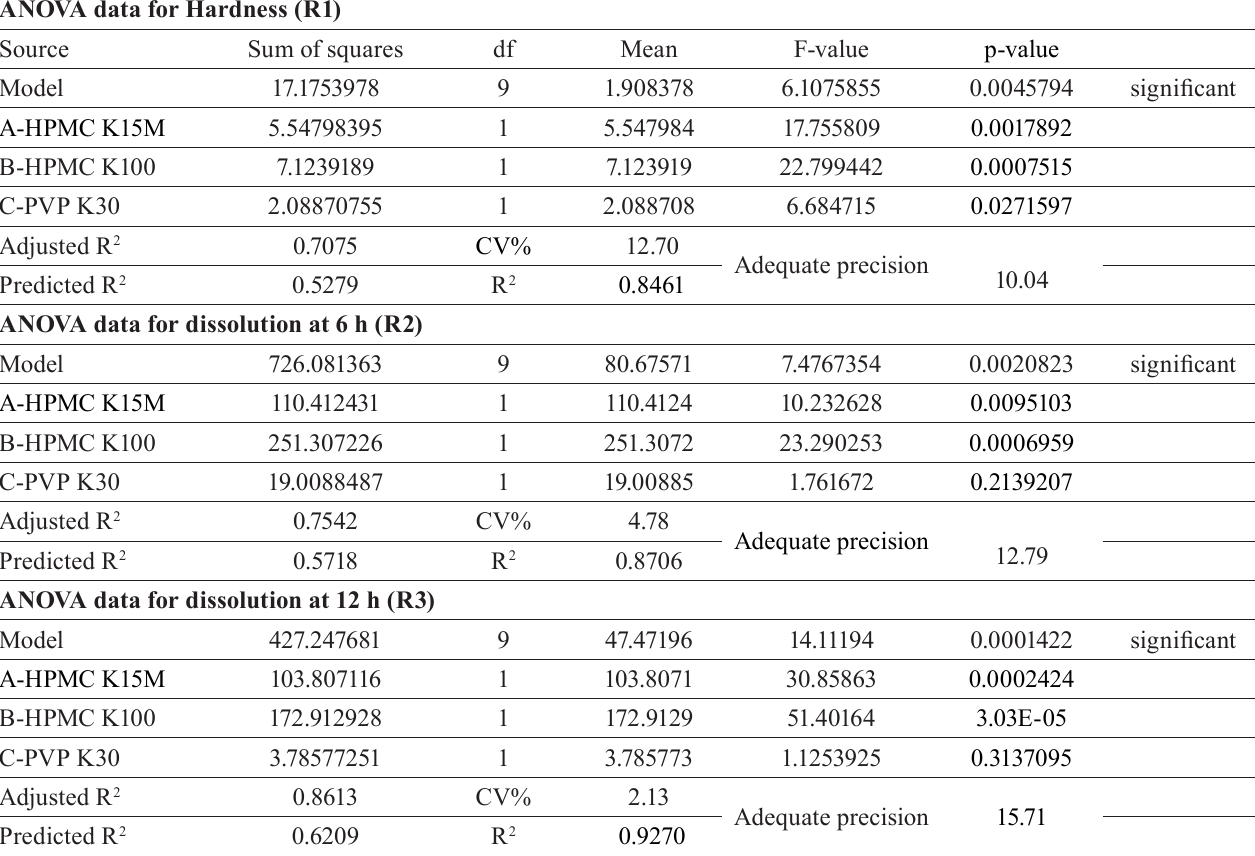
TABLE V - M odel suitability for CCD by ANOVA ANOVA data for Hardness